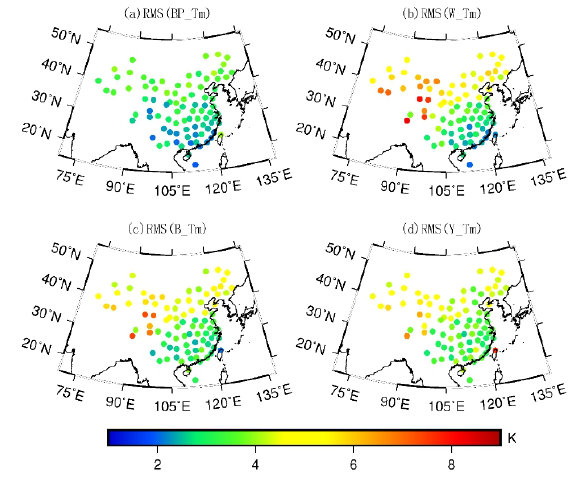
Figure 6. Distribution of RMS of different models tested using radiosonde data from 2017